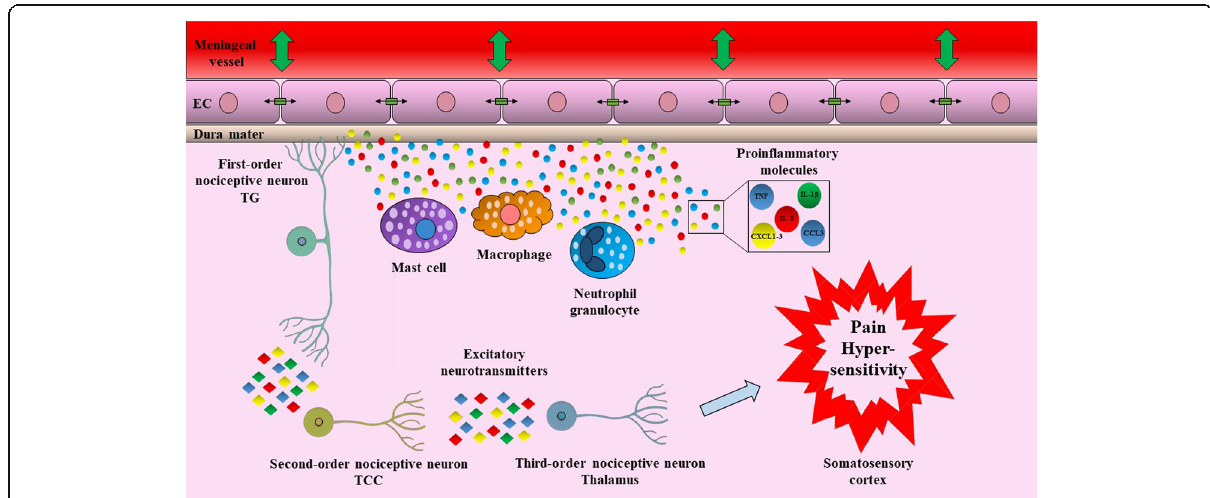
Fig. 6 Hypothetical contribution of inflammatory cytokines in migraine headache. Activation of immune cells alters the trigeminovascular microenvironment via the release of inflammatory molecules, such as cytokines and chemokines. These molecules cause vasodilation of dural vasculature and influence tight junction between endothelial cells. Activated trigeminal neurons transmit signals for the higher brain regions, which result in pain and hypersensitivity. CCL3: C-C motif ligand 3, CXCL1: C-X-C motif chemokine ligand 1, CXCL2: C-X-C motif chemokine ligand 2, CXCL3: C-X-C motif chemokine ligand 3, EC: endothelial cell, IL-1 β : interleukin-1 β , IL-8: interleukin-8, TCC: trigeminocervical complex, TNF: